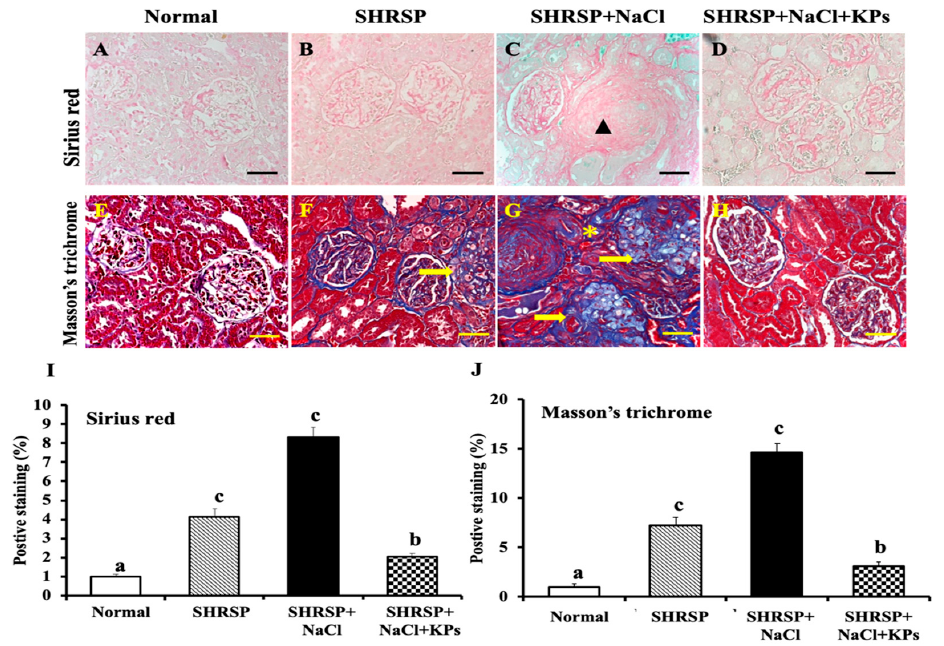
Figure 3. Sirius red and Masson’s trichrome staining of the kidney tissues of WKY and salt-induced SHRSP rats with or without KPs treatment. ( A , E ) No significant lesions were observed in the kidneys of WKY (normal) rats. The kidneys of rats in both the SHRSP ( B , F ) and SHRSP+NaCl ( C , G ) groups showed focal tubular degeneration, atrophy (*), glomerular fibrosis (yellow arrow), and arteriolar hypertrophy (black triangle). The cell structure and degree of interstitial fibrosis were analyzed at the glomerular sites (yellow arrow). ( D , H ) Less renal fibrosis was observed in the SHRSP+NaCl+KPs group. The results of the Sirius red staining show glial fibrillary structures (red; background color, green). The results of the Masson’s trichrome staining show glial fibrillary structures (blue) and muscle, cytoplasmic, and horny structures (red). Images were observed under 400× magnification. Scale bar = 50 μ m. Three fields were imaged for each individual. ( I ) Quantitative analysis of the Sirius red-positive staining (%) and ( J ) Masson’s trichrome-positive areas (%) after staining was performed with ImageJ software. Data are presented as the means ± SEMs (Normal, n = 5; SHRSP, n = 5; SHRSP+NaCl, n = 6; SHRSP+NaCl+KPs, n = 6) and were analyzed by one-way ANOVA. Data within columns that are not labeled with the same letter are significantly different ( p < 0.05), as determined using Duncan’s test.